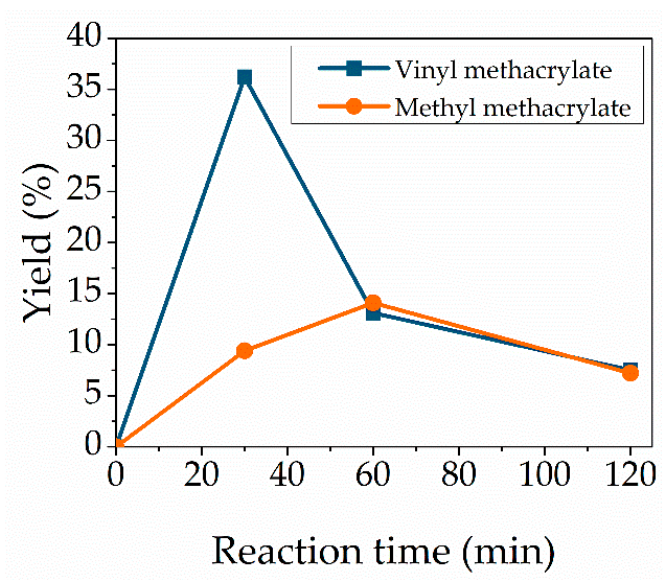
Figure 2. Effect of the choice of the substrate. Reaction conditions: cytidine (100 mg, 0.414 mmol), Novozym 435 (12.7 wt%), 95 °C, 1:35 vinyl methacrylate (blue) or methyl methacrylate (orange). Lines are included as a guide to the eye.